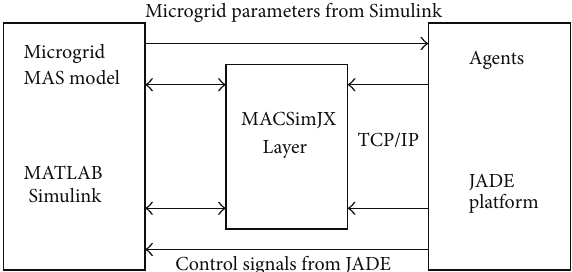
Figure 8: Multiagent system with